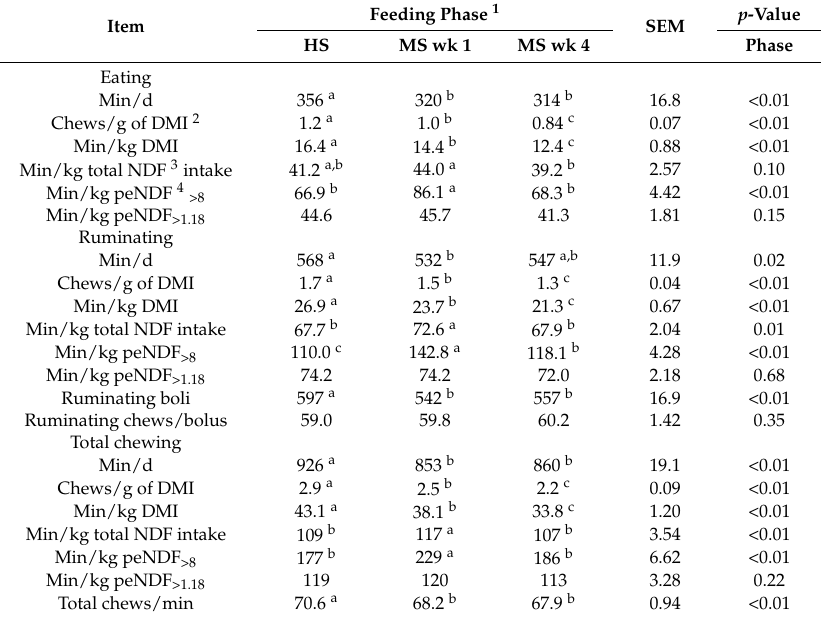
Table 3. Eating, ruminating, and total chewing behaviour in cows fed either a 40% concentrate die, high in physical structure (24.4% peNDF > 8 mm DM basis; HS), or a 60% concentrate diet with moderate physical structure content (17.6% peNDF > 8 mm;